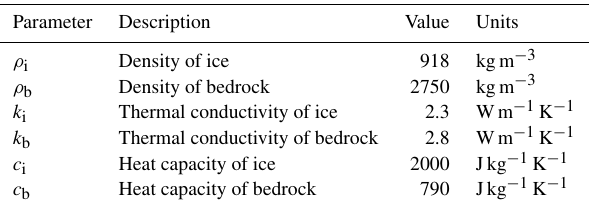
Table 1. Numerical values of the parameters used in the simula-